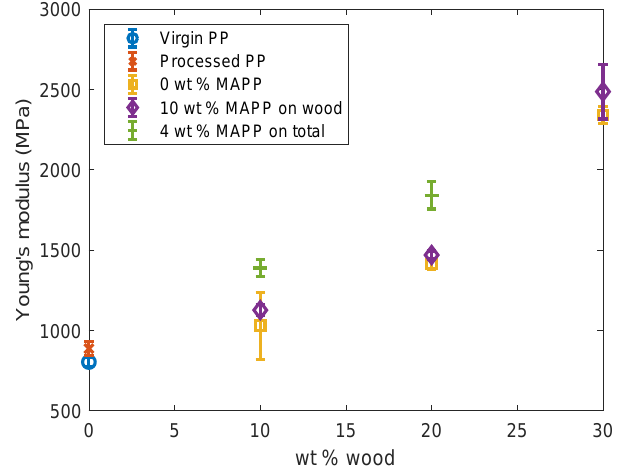
Figure 5. Young’s modulus as a function of filler percentage for various